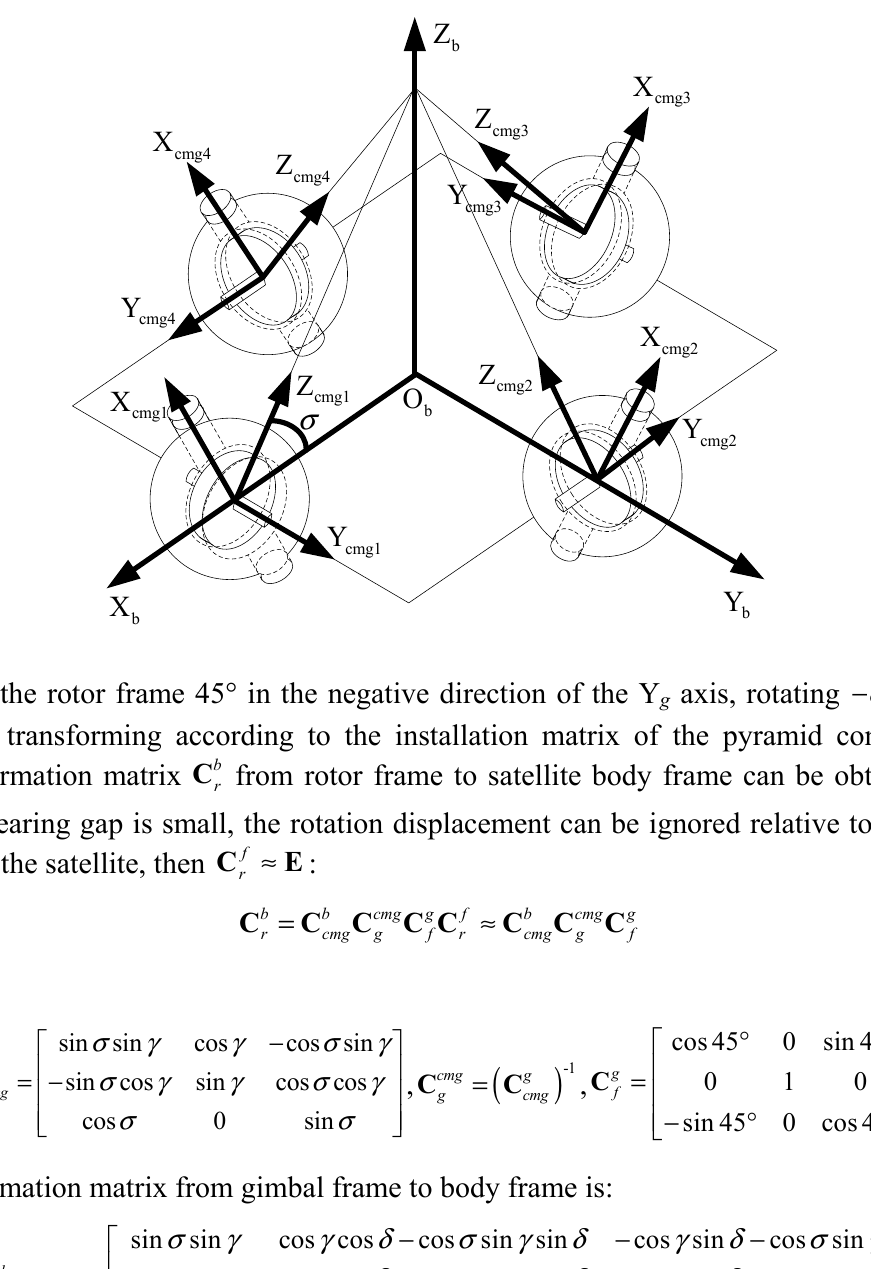
Figure 4. The pyramid configuration installation of four magnetically suspended